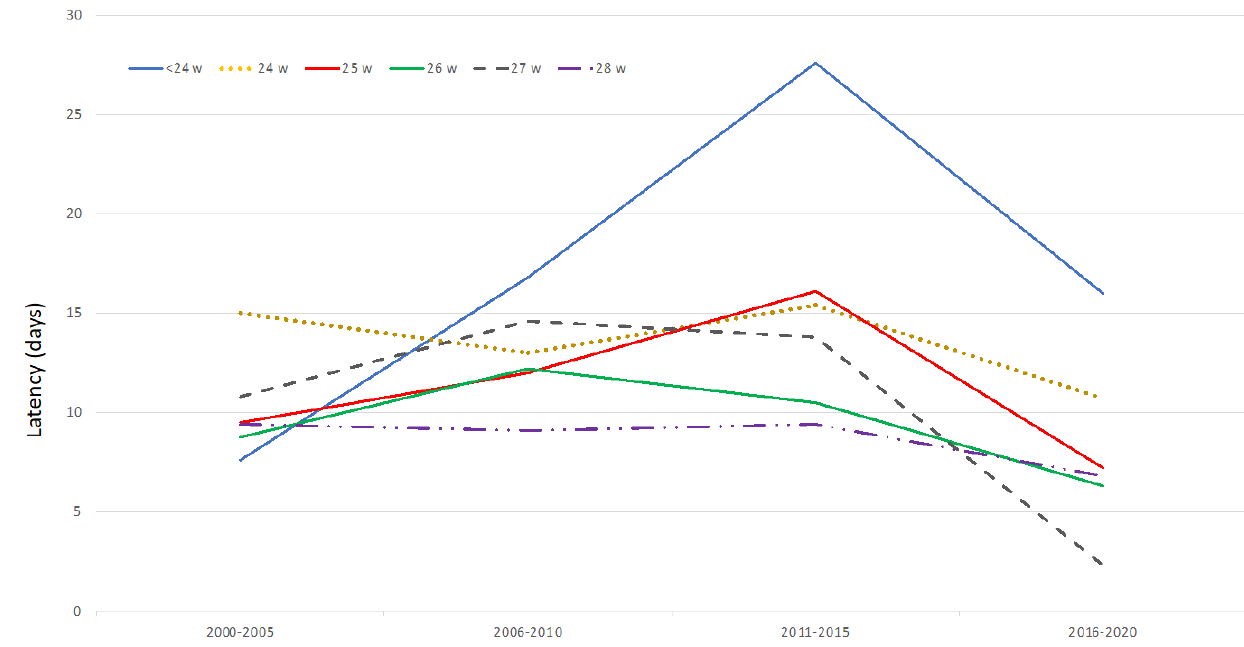
Figure 5. Mean latency period between PPROM and delivery in groups of gestational age at PPROM